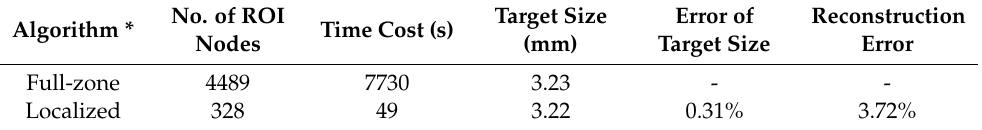
Table 2. Mesh parameters and performance comparison between the conventional full zone- based FE-PAT algorithm and the localized FE-PAT algorithm in various ROI sizes for phantom experimental